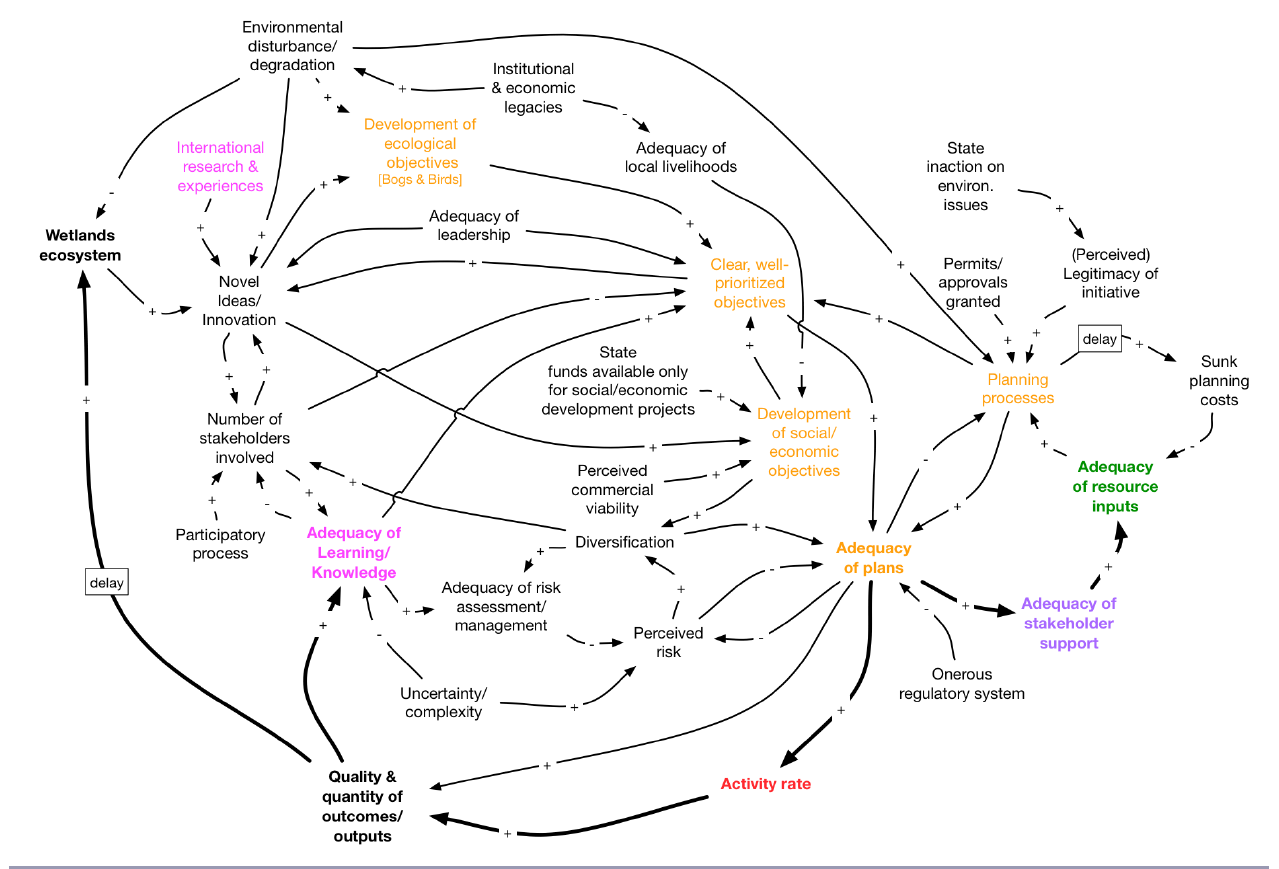
Fig. 5 . Submodel unpacking the causal dynamics influencing the adequacy of planning for wetland restoration initiatives in Belarus. Core drivers and processes are in bold. Colored, nonbolded variables represent specific concepts unpacked from within respective core processes. E.g., Clear, well-prioritized objectives is a facet of adequacy of planning. Thick lines represent links between core drivers/processes. Several variables recur throughout Figures 5–9, representing points where core process dynamics link together in an integrated